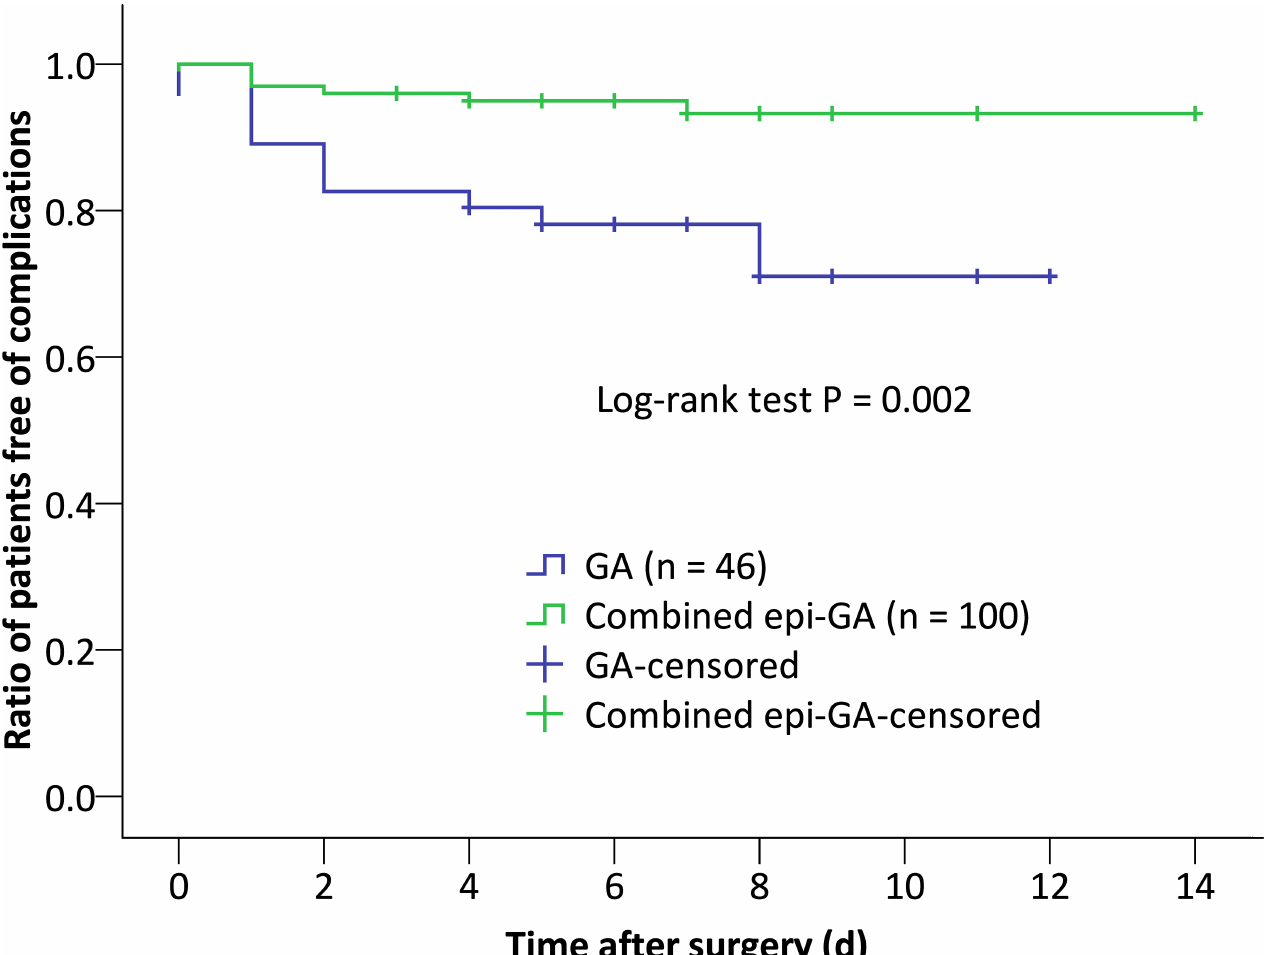
Fig 2. Ratio of patients free of postoperative complications. Postoperative complications were defined as grade II or higher on the Clavien-Dindo classification. PC = postoperative complications.